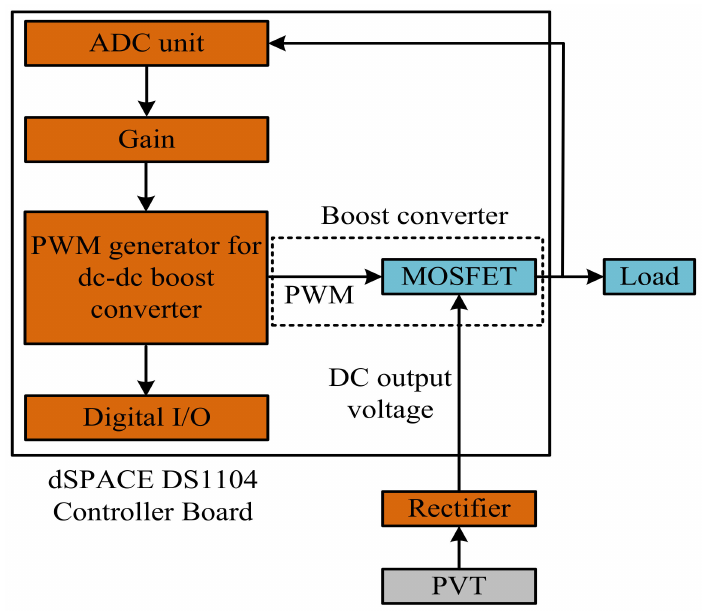
Figure 5. Flow chart of the dSPACE DS1104 controller